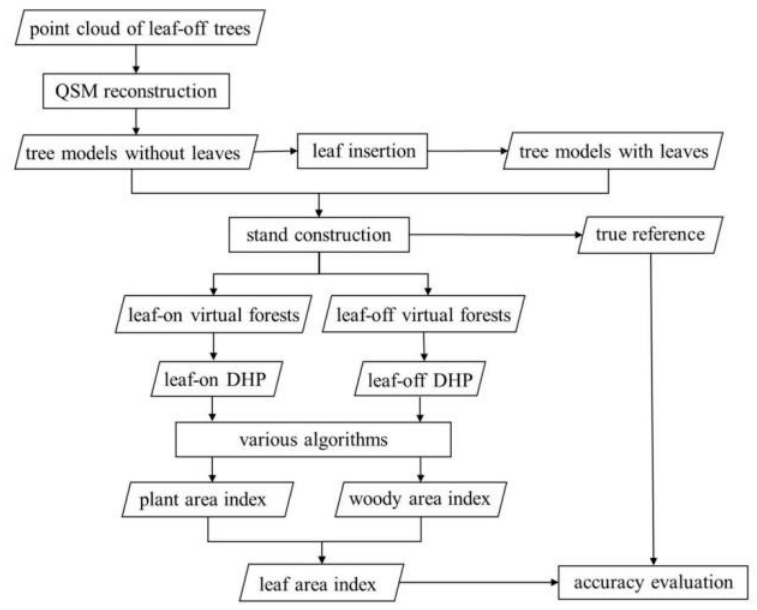
Figure 1. The flowchart of accuracy comparison of different forest LAI estimation algorithms in digital hemispherical photography programs (including Can_Eye, CIMES, and Hemisfer).